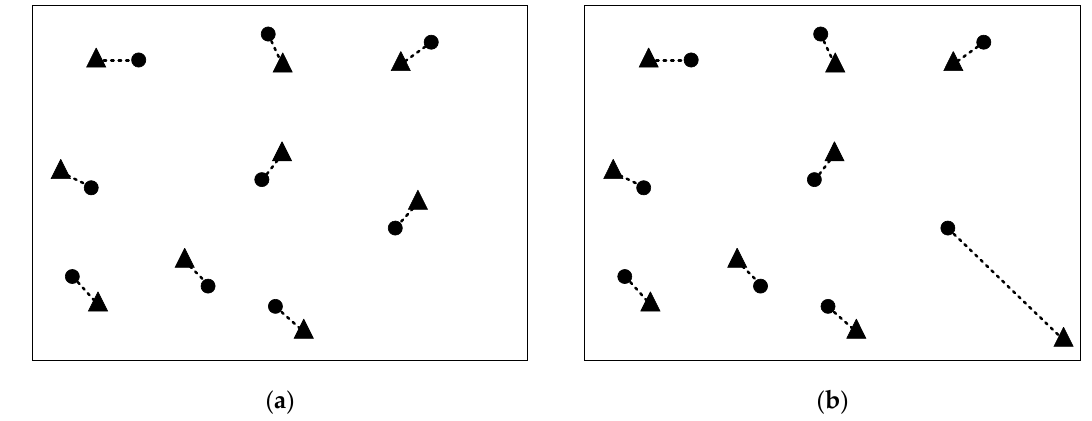
Figure 3. Simple examples of measurement D . ( a ) The distances between the dots and the nearest triangle (connected with a dotted line) are 1. ( b ) The distances between the dots and the nearest triangle are 1 with an outlier in the lower right corner with a distance of 10.